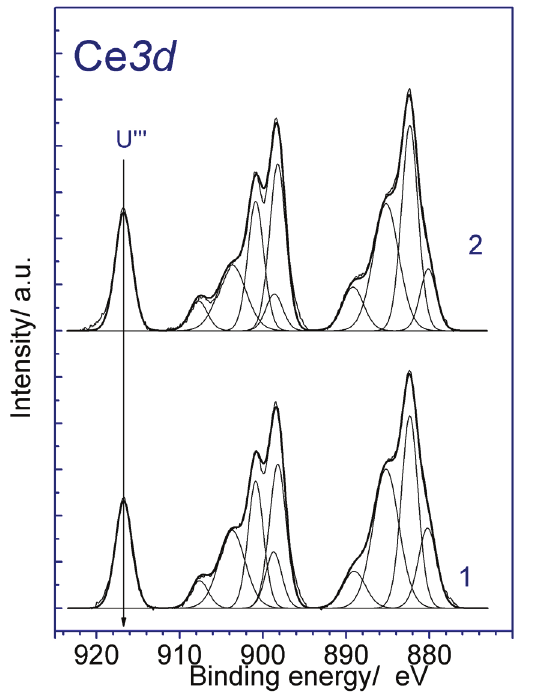
Zr O sample as prepared (1) 0.5 0.5 2